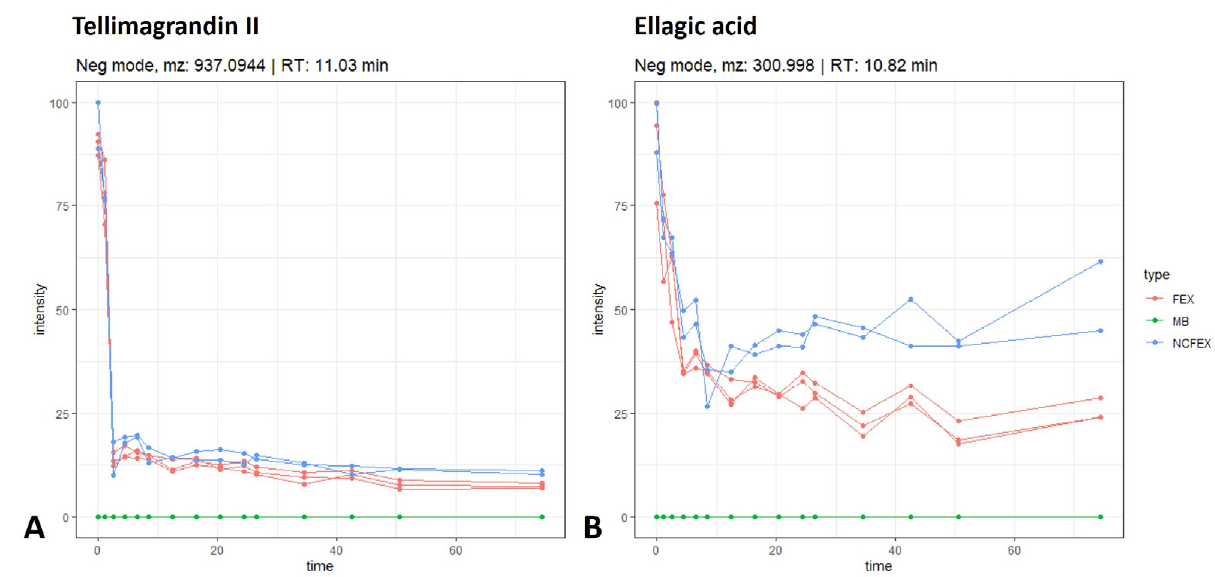
Figure 7. Time pro fi les (time in hours) of tellimagrandin II ( A ) and ellagic acid ( B ) during gastroin- testinal biotransformation. See also legend of Figure 2.